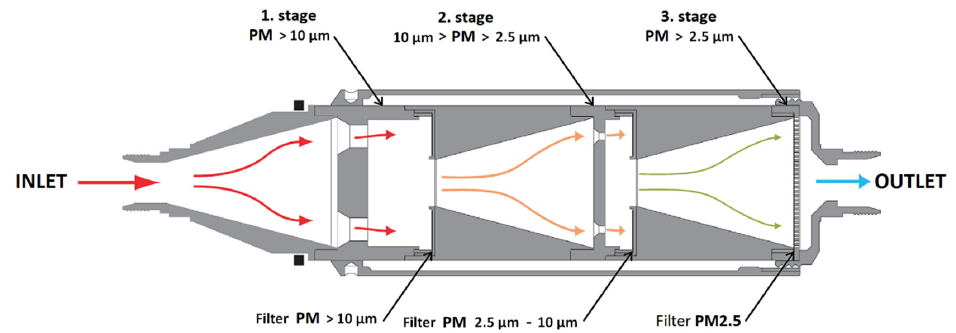
Figure 2. The principle of the used gravimetric probe.